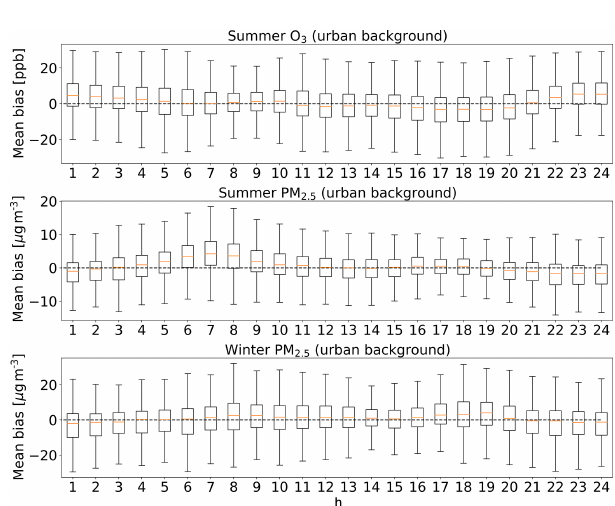
Figure 2. Hourly mean bias of simulated surface O 3 (summer) and PM 2 . 5 (summer and winter) concentrations calculated during the year 2017 over 15 and 6 urban background monitor sites, respec-